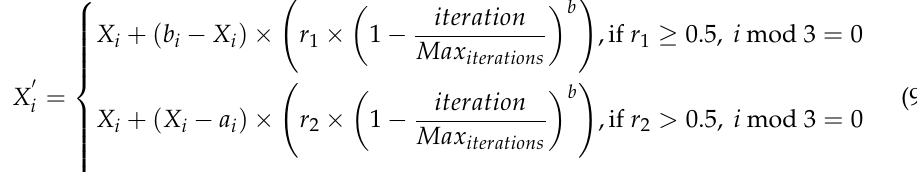
Figure 1. A flowchart of the proposed Distributed Bi-behaviours Crow Search Algorithm (DB-CSA). The mutation operators in [79] are added to maintain more diversity in the flock of N crows. The nonuniform and the boundary mutation operators in Equations (9) and (10) are applied to modify the variables X i = X i , X i , . . . , X i of each crow i , according to the proba- 2 1 d bility mutation P m equal to 1/ d , where d is the dimensional search space and X i ∈ [ a i , b i ] where a i and b i are the lower and upper bounds, respectively. The nonuniform mutation in Equation (9) is applied when the modulo value (mod) that divides the crow position i by three is equal to zero. However, if the remainder is equal to one, the boundary mutation in Equation (10) is used. Otherwise, all variables are considered without mutation